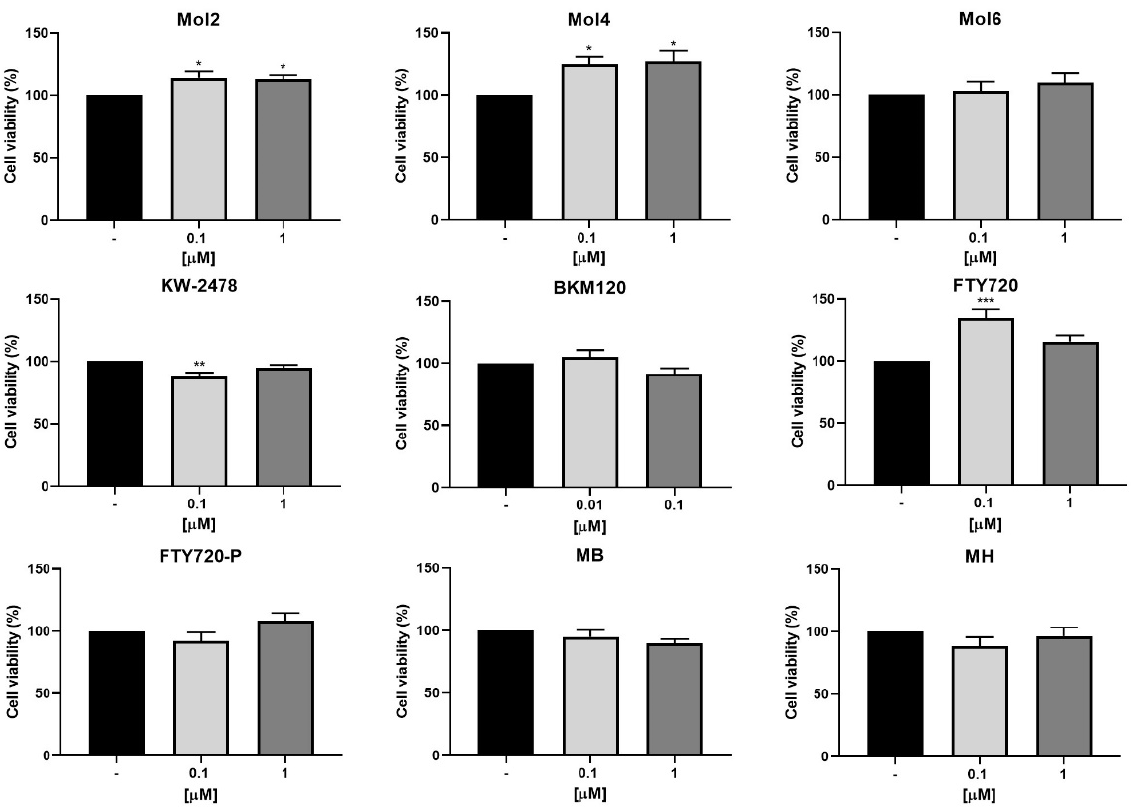
Figure 2. The 4T1 cells viability upon exposure to drugs. The 4T1 cells were treated with the indicated concentrations of each drug, or DMEM (untreated), for 24 h. Cell viability was assessed by MTT assay, and the values are presented as percentage relative to untreated cells. All values are mean ± SEM of three independent experiments performed in triplicate. Statistical significances are shown as * p < 0.05, ** p < 0.01, and *** p < 0.001 vs. untreated.